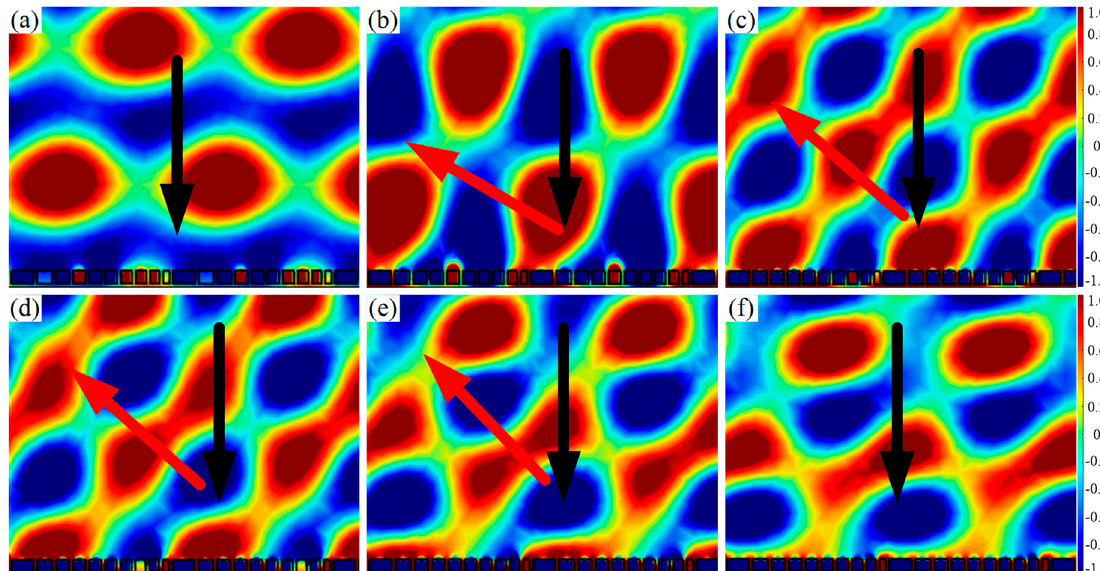
Figure 5. Reflected acoustic pressure field distribution of the AMS of SHCs with different lengths at the phase gradient of π /122 rad/mm. ( a ) 1625 Hz; ( b ) 1645 Hz with 60.1 ◦ ; ( c ) 1875 Hz with 49.2 ◦ ; ( d ) 1900 Hz with 48.3 ◦ ; ( e ) 1950 Hz with 46.0 ◦ ; and ( f ) 2000 Hz.